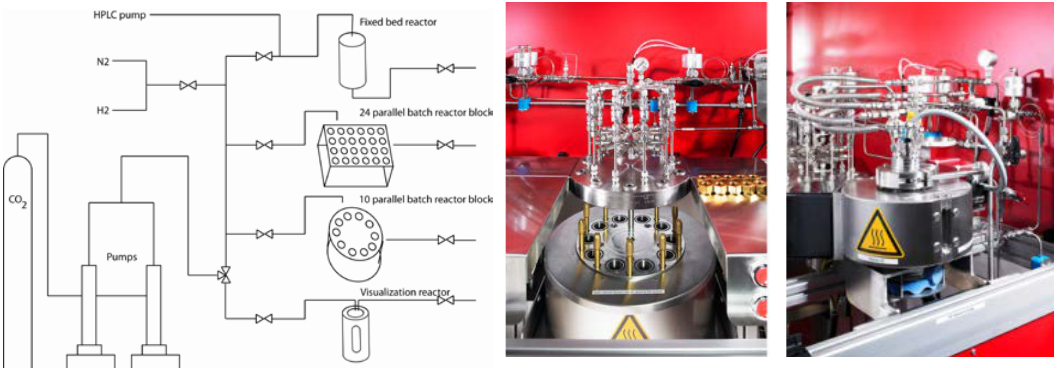
Figure 4. From left to right: schematic overview of the high-throughput scCO 2 unit used to prepare the TiO 2 -SiO 2 composites; reactor block with 10 batch reactors; visualisation reactor used to monitor the phase behaviour during the synthesis. (Adapted with permission from [42]. Copyright Wiley-VCH, 2011).